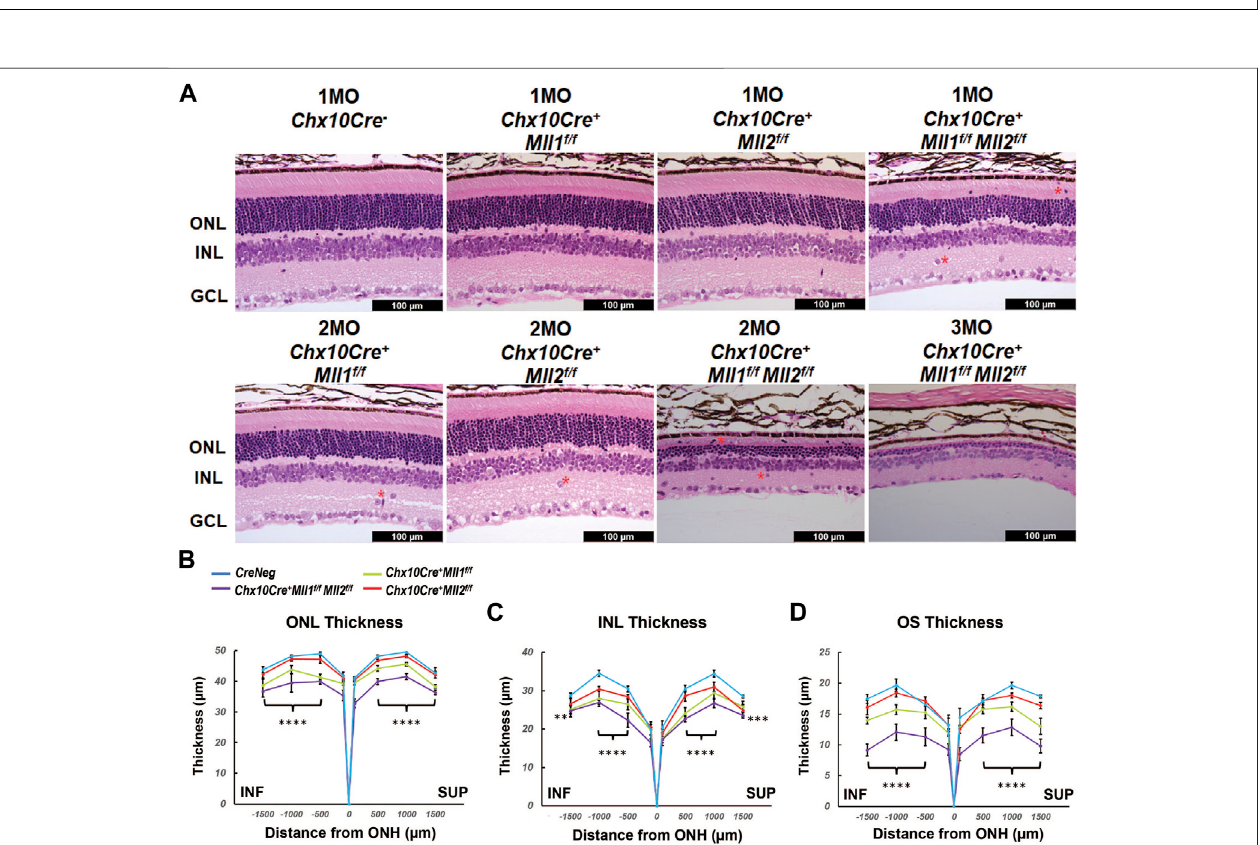
FIGURE 3 | Morphological defects of Mll mutants. (A) Hematoxylin and Eosin (H&E) cross-section staining of mature mutant and control retinae. Top panels show representative images of 1MO retinae of the indicated genotypes. Bottom panels show representative images of 2MO or 3MO retinae of the indicated genotypes. Red asterisks indicate mislocalized cells. ONL: outer nuclear layer; INL: inner nuclear layer; GCL: ganglion cell layer. Scale bar = 100 µm for all image panels. (B) ONL thickness (µm) in 1MO retinae at the indicated positions from the optic nerve head (ONH). SUP and INF indicate superior and inferior sides of the retina. Error bars representmean(SD) ( n ≥ 4). (C) INL thickness in 1MO mutant and controlretinae( n ≥ 4). (D) Outersegment(OS) thickness in 1MO mutant and controlretinae ( n ≥ 4). All statistics is done by two-way ANOVA and Tukey ’ s multiple comparisons. Results of statistical analysis between the double CKO and CreNeg retinae are shown. Asterisks (**, ***, ****) denote p ≤ 0.01, p ≤ 0.001, p ≤ 0.0001 respectively.